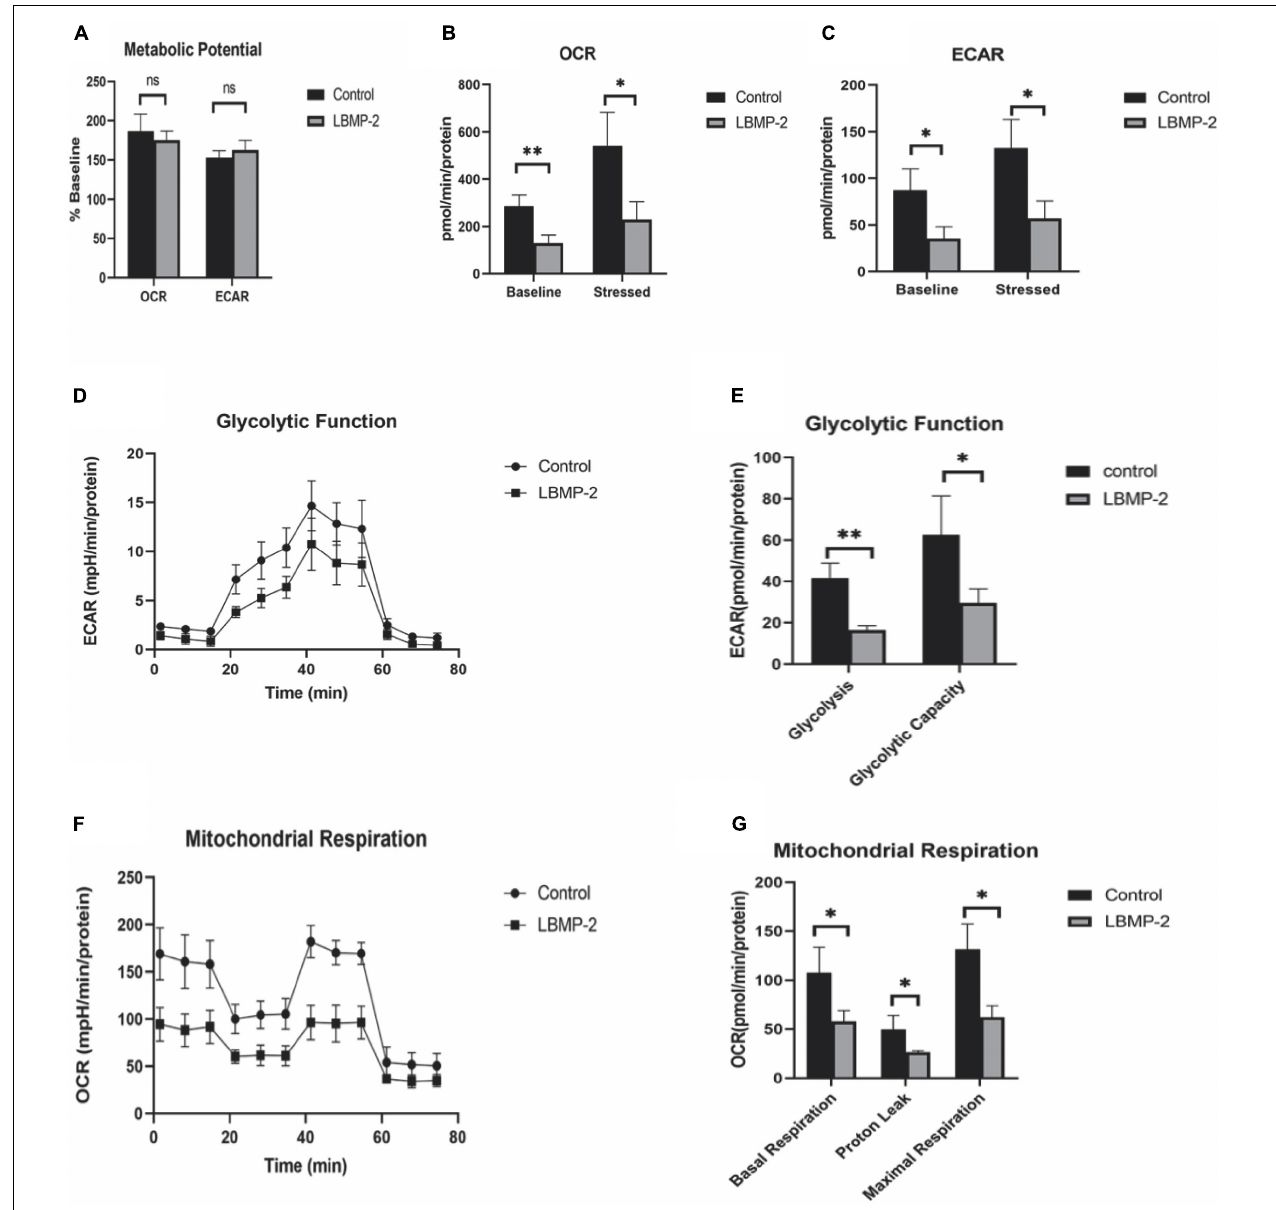
FIGURE 4 | The effect of LBMP-2 on the metabolism of B16-F10 cells. (A–C) Energy metabolism phenotype. (D,E) Glycolytic metabolism. (F,G) Aerobic Respiratory. (* P < 0.05, ** P < 0.01, and ns: no significant